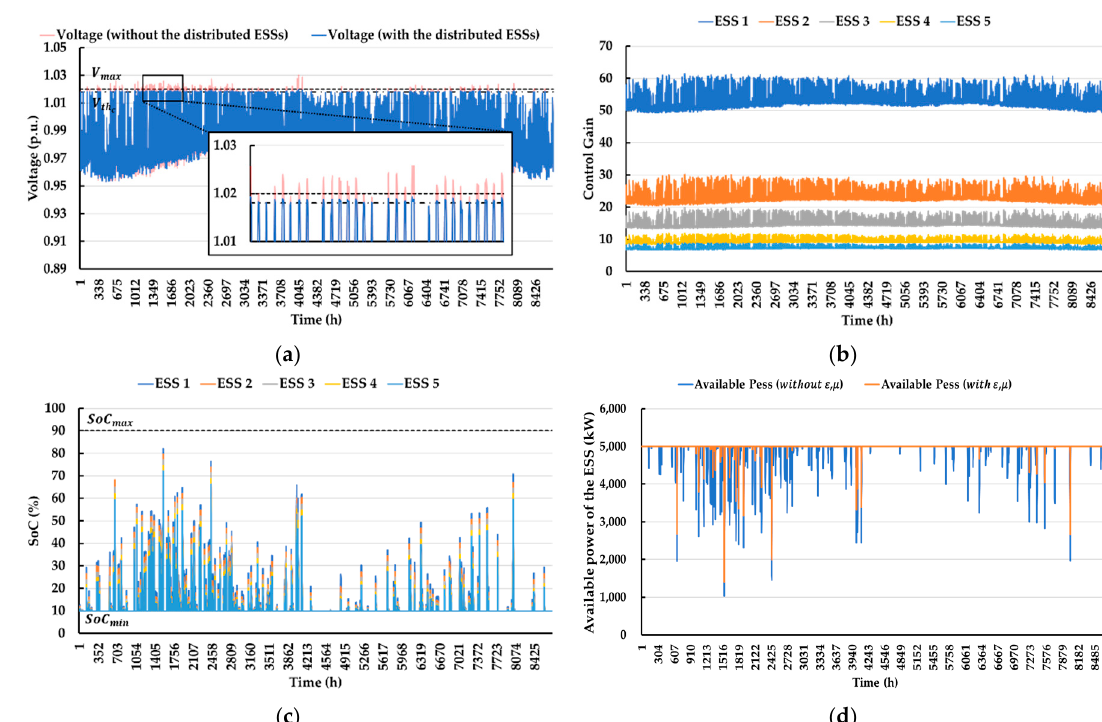
Figure 16. Annual simulation results: ( a ) Voltage profile; ( b ) Control gain of distributed ESS; ( c ) SoC profiles; ( d ) Available power of the distributed ESS.